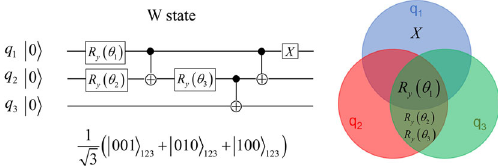
a a (cid:6) e i α 1 2 a a (cid:6) e i α Þ is a 1-qubit unitary 2 (cid:2) 1 p the state becomes 2